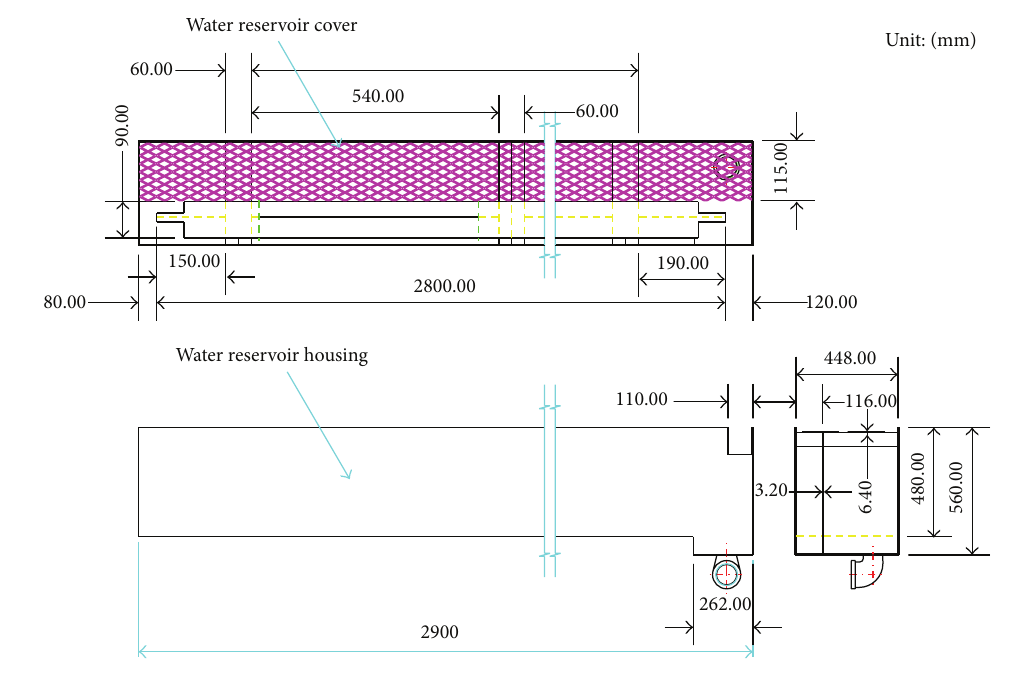
Figure 6: Water reservoir installed below the rolling door.